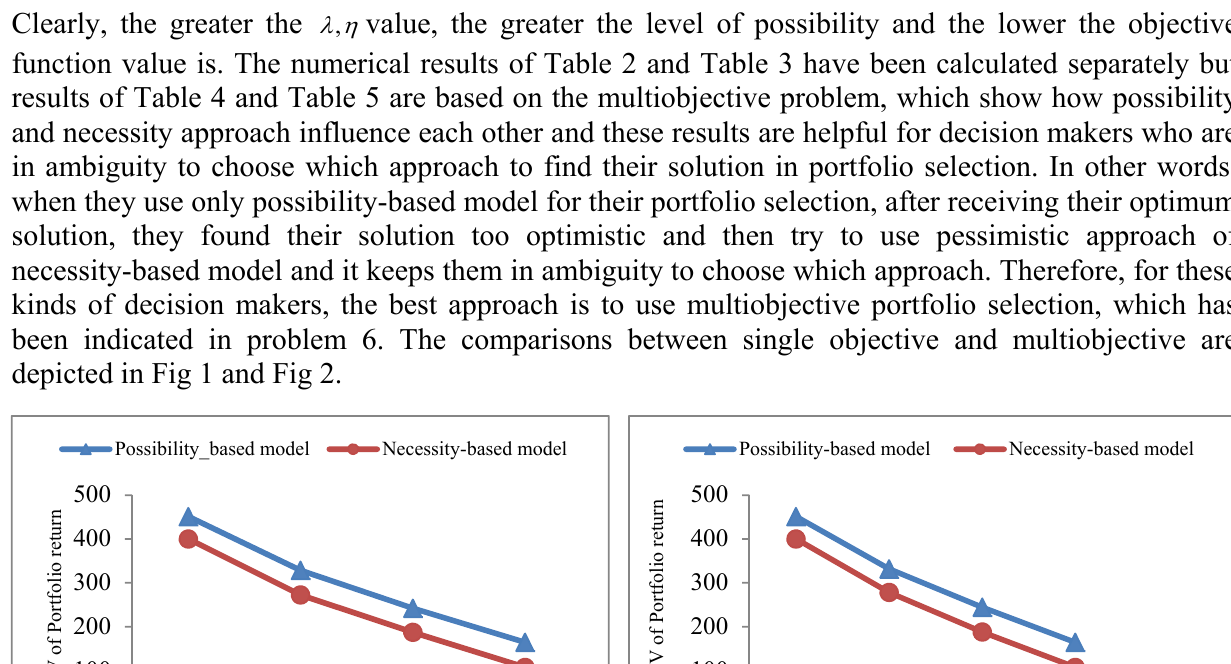
Fig. 2. Comparison of Possibility and Necessity-based model in